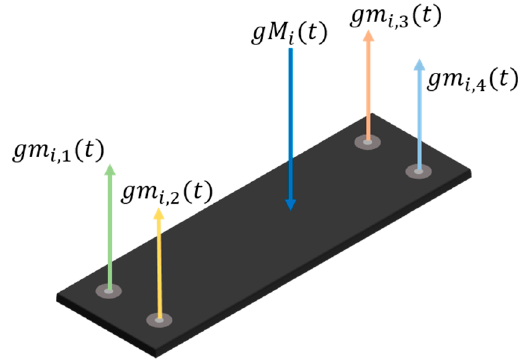
Figure 2. Constraint reactions of the load cells and total applied force.